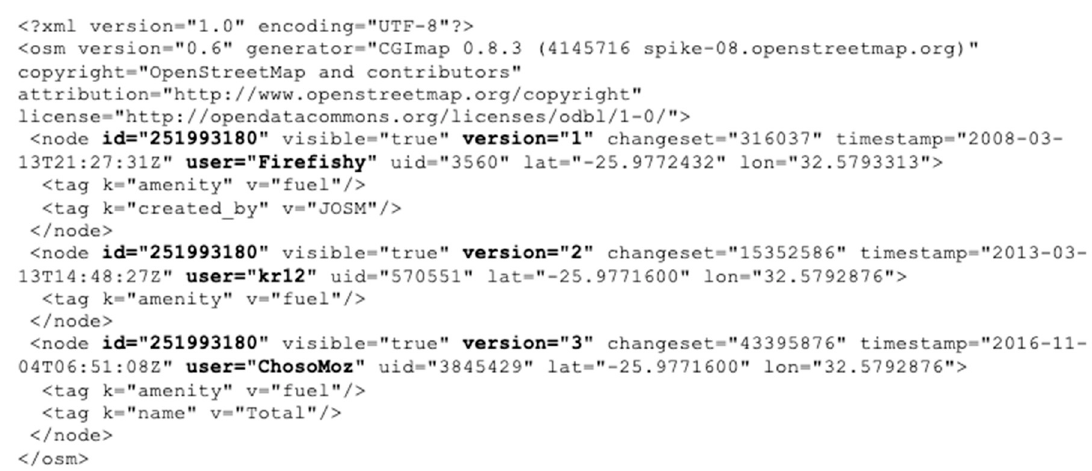
Figure 2. Three records from the OSM history file, showing edits to a single node (id=251993180).